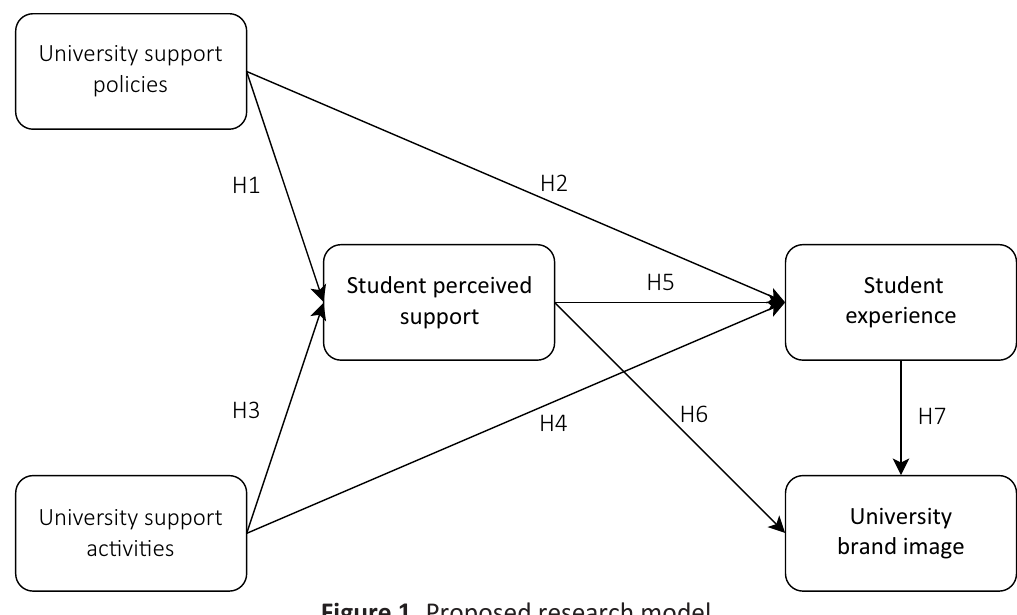
Figure 1. Proposed research